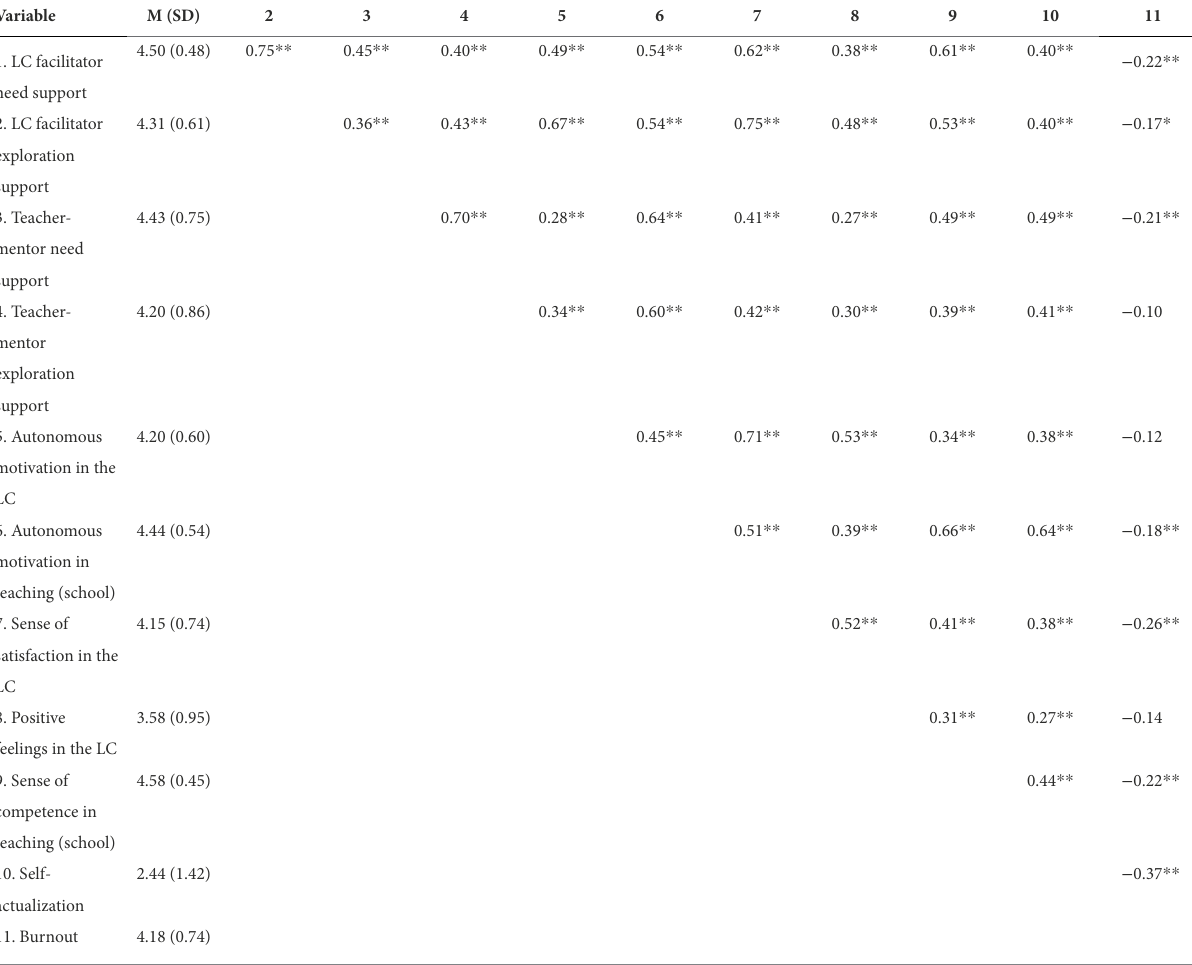
TABLE 2 Descriptive statistics and correlations between the research variables at